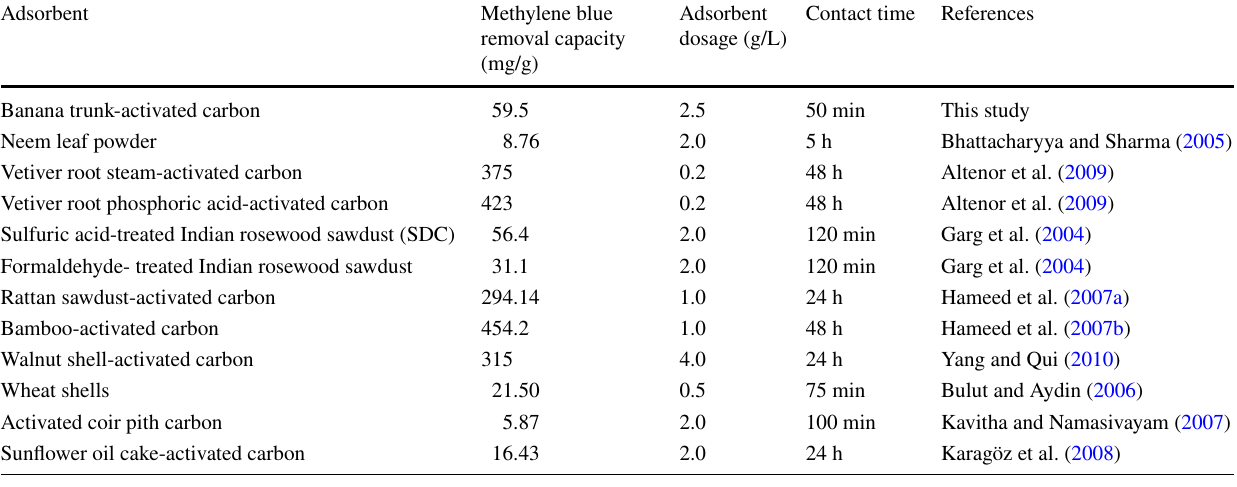
Fig. 4 Fourier transform infra- red (FTIR) spectrum of banana trunk-activated carbon (run number